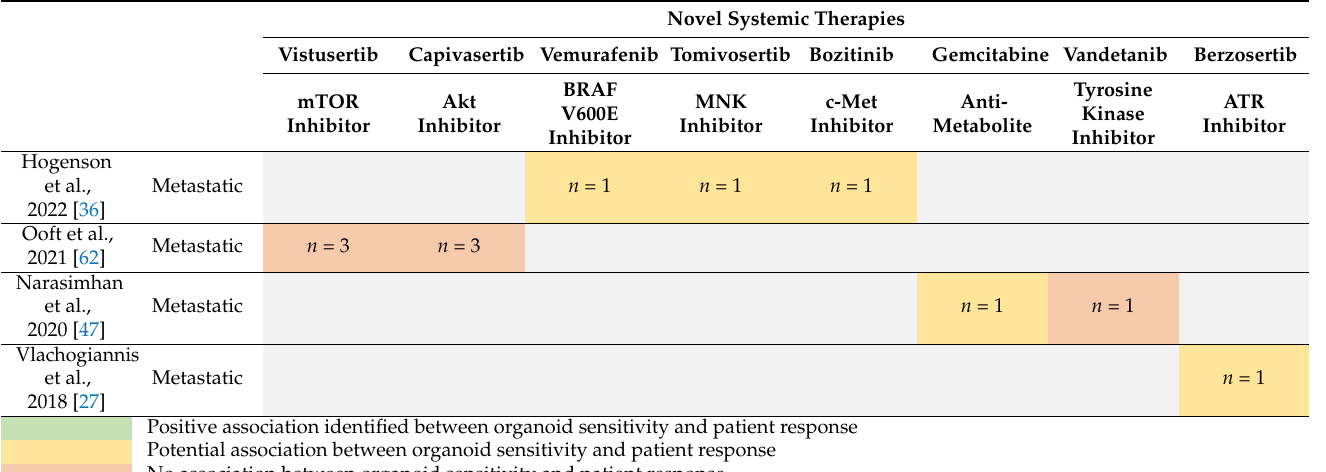
Table 2. Summary of studies associating organoid sensitivity and patient response to novel systemic